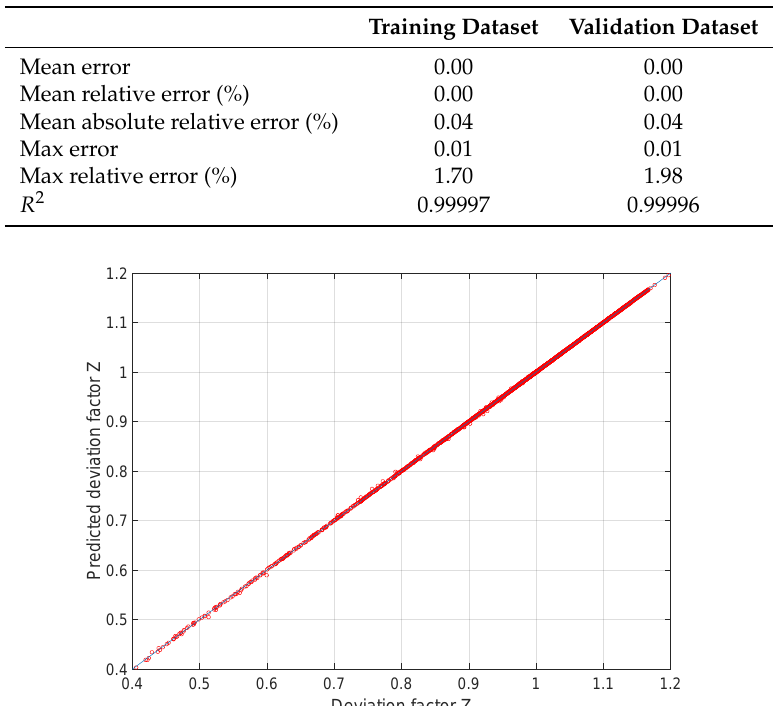
Table 1. Performance of the Truncated Regularized Kernel Ridge Regression (TR-KRR) model.